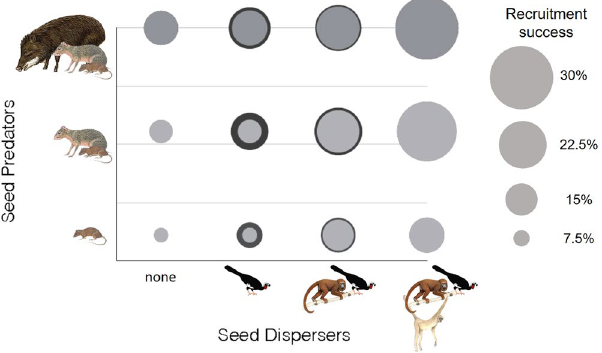
Figure 2. Expected recruitment success of C. mandioccana with and without compensation effect of the disperser community. The loss of seed dispersers was simulated in the area where the complete assemblage of seed dispersers is currently present (Carlos Botelho State Park, highlands) and the recruitment success of C. mandioccana estimated in three scenarios of seed predator communities. The simulations give the expected recruitment success in different scenarios of seed disperser (x axis) and seed predator (y axis) communities considering (dark grey circles) or not (light grey circles) compensation effects of the disperser community. The contribution of the disperser community in the compensation scenario is based on the data collected in Cardoso Island (community without muriquis) and in the lowland part of Carlos Botelho State Park (community without muriquis and howler monkeys). (Illustrations of: muriqui and howler monkey - Copyright Stephen D. Nash; peccary, agouti, and rodent – Copyright Fiona A. Reid; jacutinga – Copyright Fabio Martins Labecca, authorized by the